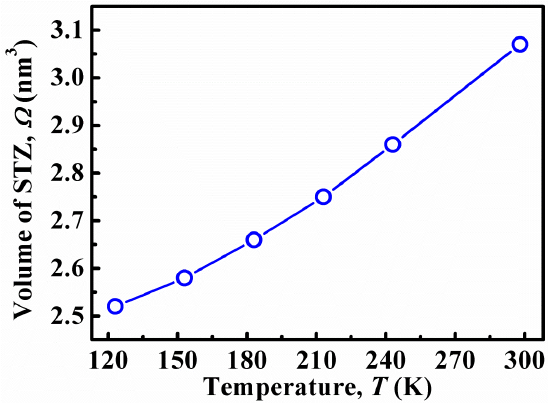
Figure 8. The shear transformation zone (STZ) volume as a function of temperature.